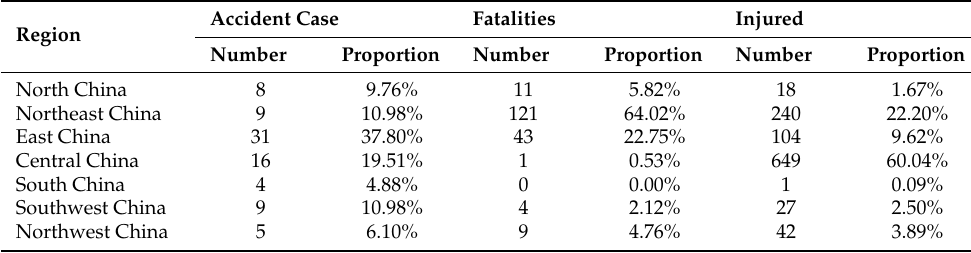
Table 4. Number of accidents, fatalities, and injuries by seven administrative geographical regions.